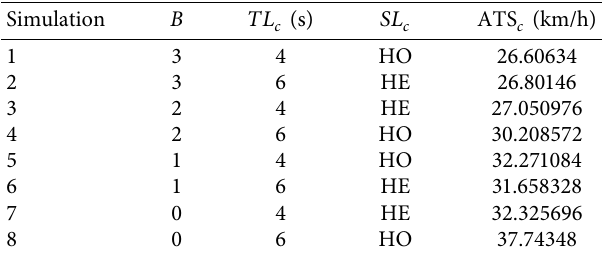
Table 6: ANOVA results (experiment